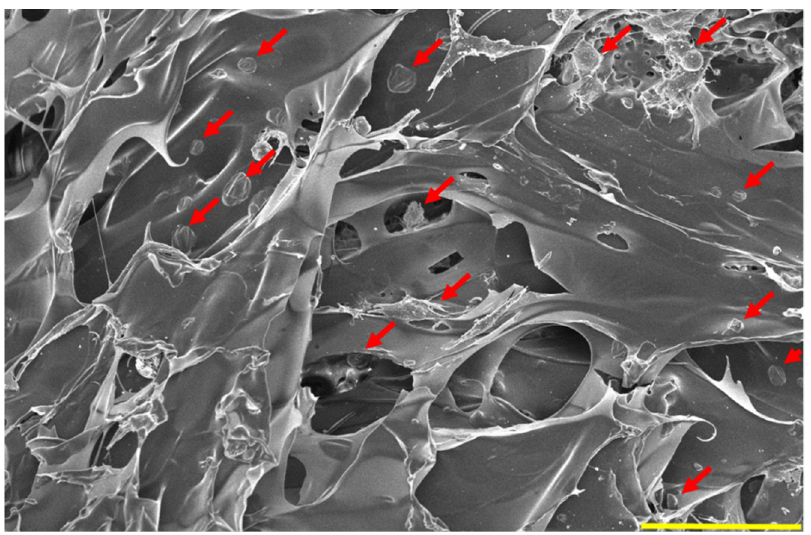
Figure 10. DFATS attachment property of α -TCP/GS. DFATs, dedifferentiated fat cells; α -TCP/GS, composite gelatin sponge. The red arrows indicate DFAT. The yellow scale bar represents a length of 50 μ m.